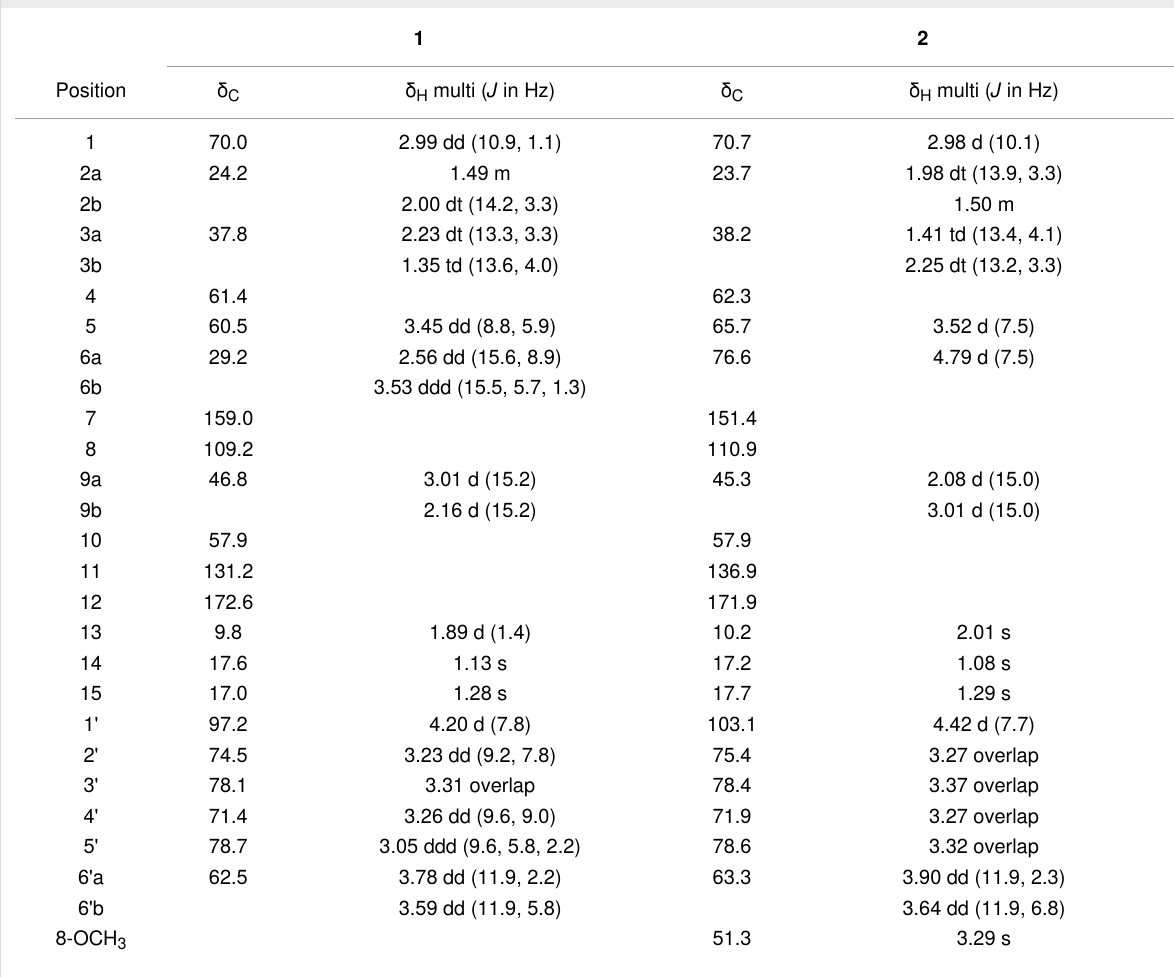
Table 1: 1 H (700 MHz) and 13 C (175 MHz) NMR data of compounds 1 and 2 in methanol- d 4 . 1 2 δ C δ H multi ( J in Hz) δ Position